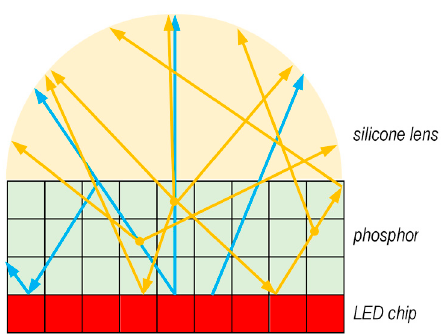
Figure 14. Some light paths in an LED: Blue light comes from the chip, yellow light is generated in the phosphor.